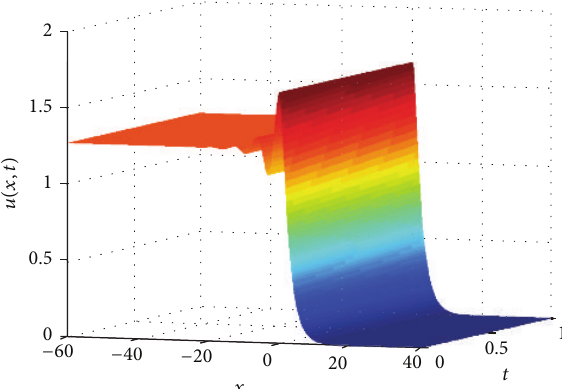
Figure 17: Plot of the approximate damped oscillatory solution (33) with 𝑎 = −0.2 , 𝑏 = 0.6 , 𝑐 = 0.2 , 𝑝 = 2 , 𝛽 = 1 , and 𝑟 = −0.5 .